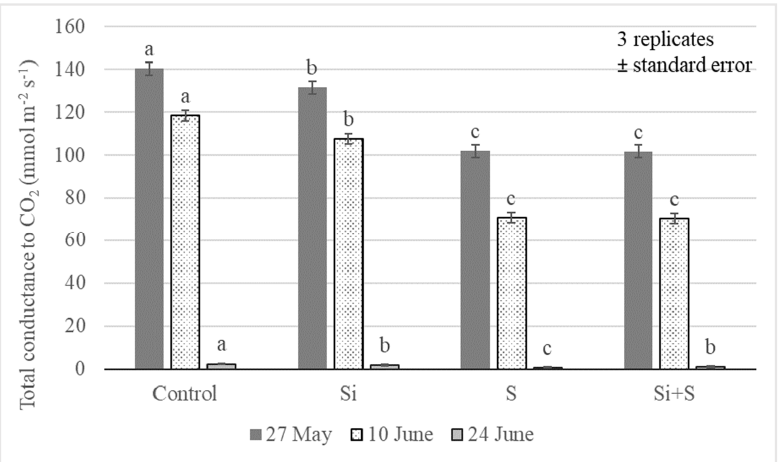
Figure 8. Total conductance to CO 2 (GTC) in oat leaves as an effect of the treatments (Debrecen, 2021); Means of the varieties, ± standard error. The differences among the treatments were significant at p = 0.01. The different lower-case letters (a–c) represent significant difference at p < 0.05 among the treatments. When the letters on the different treatments are the same, it means there is no significant difference between them. Table 1. Pearson correlation coefficient values between WUE, VPD, and assimilation parameters in winter oat (2021, Debrecen). Ci GSW Transp